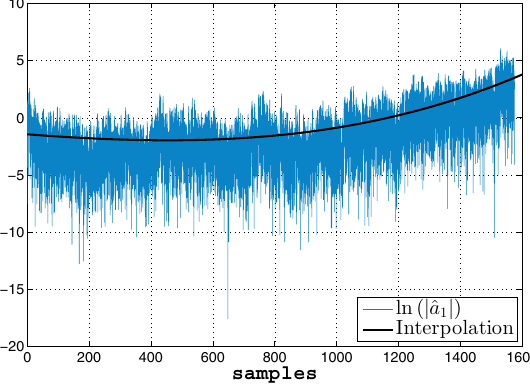
Figure 9. Example 4. log | a 1 | vs.